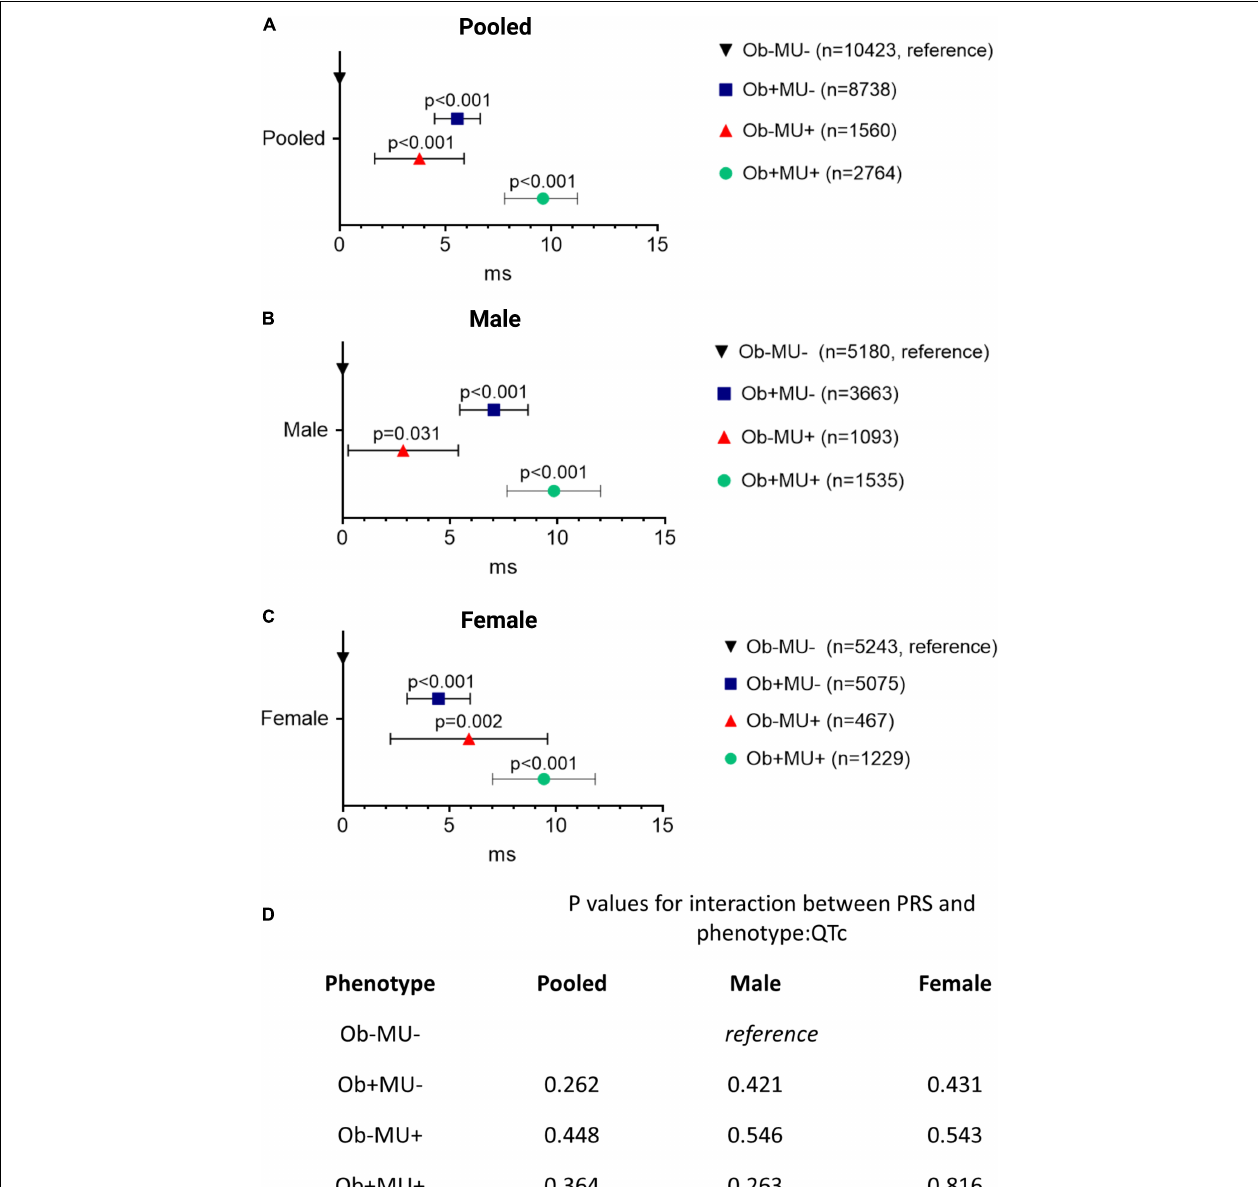
FIGURE 4 | Obesity and metabolic perturbation are independently associated with longer QTc interval and their effects are additive when they co-exist. Differences in the QTc interval ( (cid:49) QTc) referenced to the non-obese metabolically healthy (Ob-MU-) group for each clinical phenotype, in pooled (A) and sex-stratified (B,C) analysis. The p -values for the interactions between PRS and phenotype:QTc are shown in the in-set table (D) Ob, obese; MU, metabolically unhealthy; +, presence; –, absence; CI, confidence interval; PRS, polygenic risk